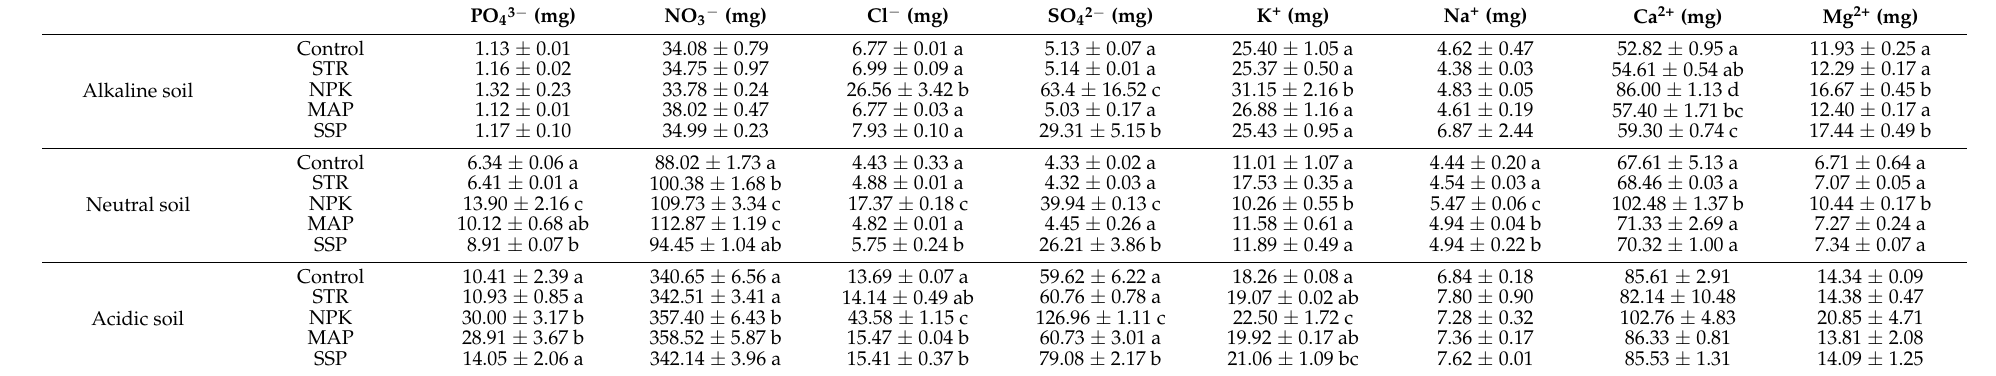
Table 4. Chemical composition of cumulative leaching. Values followed by different letters indicate significant differences ( p < 0.05, Duncan’s test).